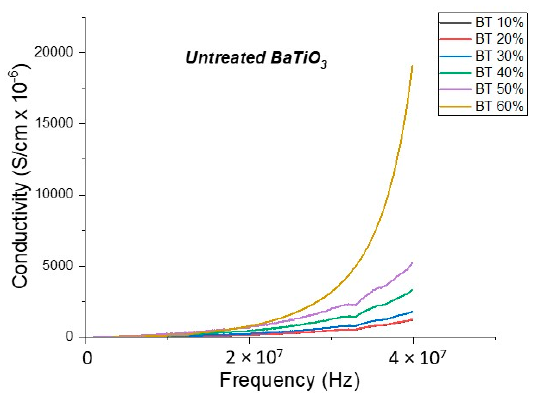
Figure 19. The conductivity of the BaTiO 3 -epoxy composite that were BaTiO 3 nanoparticles which were not surface treated (pristine) is plotted as a function of frequency. The maximum value of conductivity at 20 MHz is 7.84 × 10 − 4 S/m and occurs at BT 0.6.